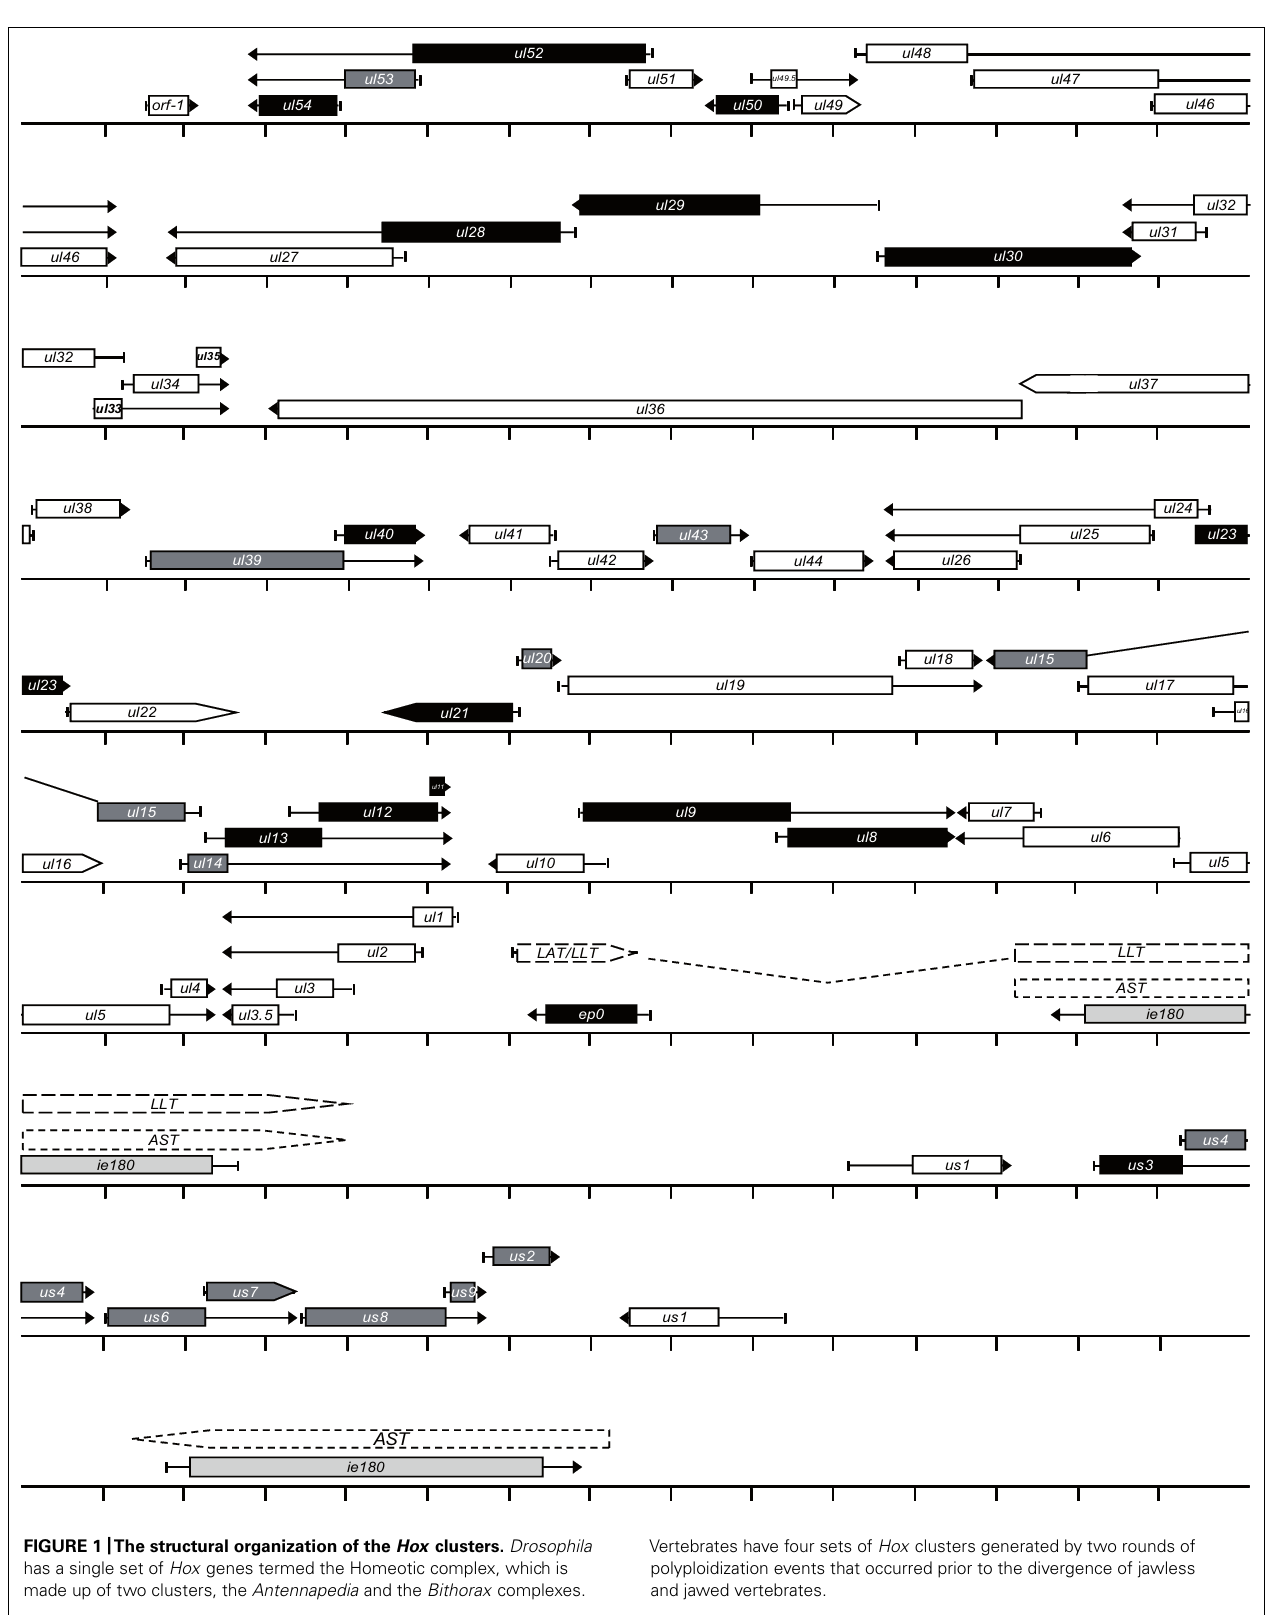
FIGURE 1 |The structural organization of the Hox clusters. Drosophila has a single set of Hox genes termed the Homeotic complex, which is made up of two clusters, the Antennapedia and the Bithorax complexes.